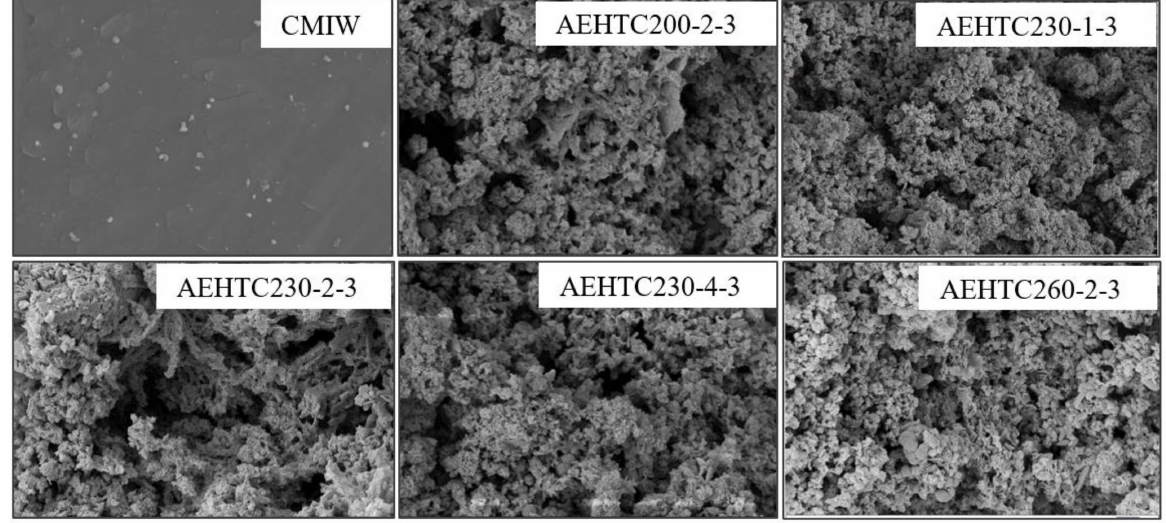
Figure 2. Contrast analysis diagrams of surface microstructures of CMIW and AE-CMIW